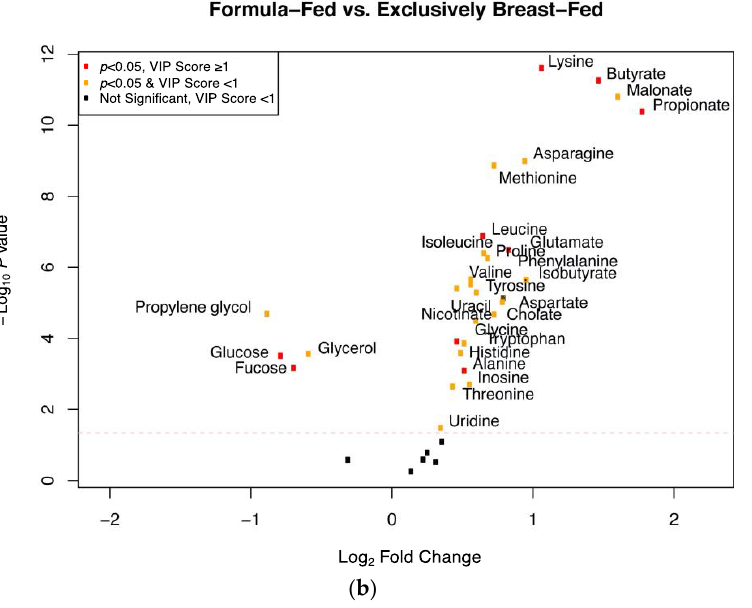
Figure 3. Associations between relative concentrations of metabolites and delivery mode and feeding method. ( a ) Delivery mode. Positive log 2 fold change values indicate associations with Cesarean section delivery while negative log 2 fold change values indicate associations with vaginal delivery. ( b ) Feeding method. Positive log 2 fold change values indicate associations with formula feeding (combination fed and exclusively formula fed) while negative log 2 fold change values indicate associations with exclusive breast feeding.